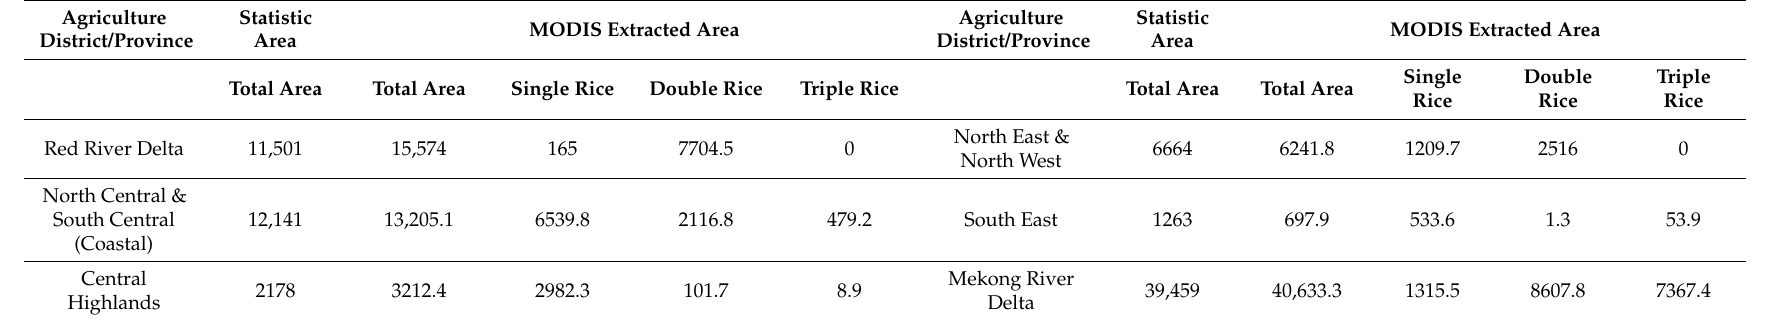
Table 3. Statistics of rice cropping areas in each province derived from